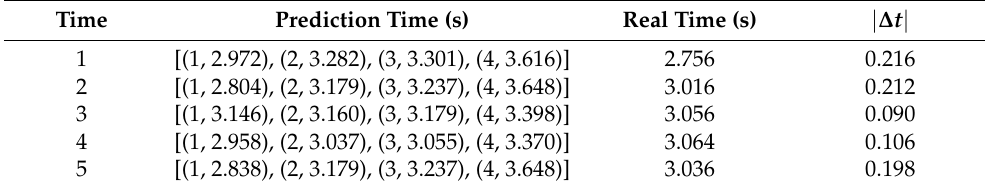
Table 5. The consuming time of the crane for the sorting task with scheduling strategy.